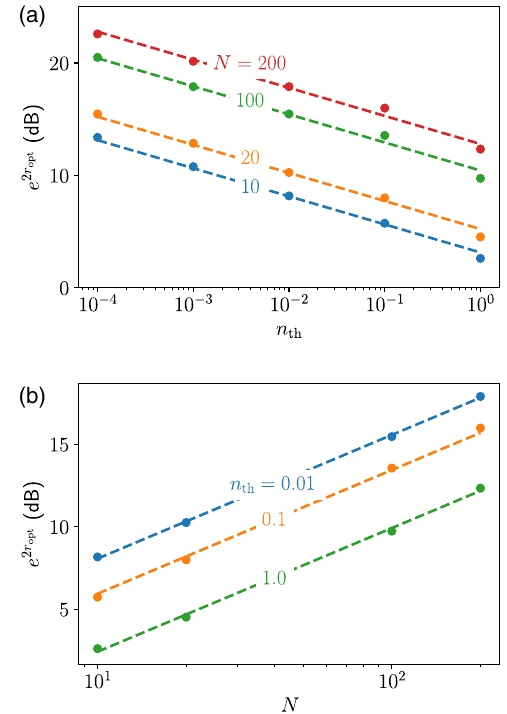
opt and N , r is th opt . (a) Scaling of e 2 r opt R . th